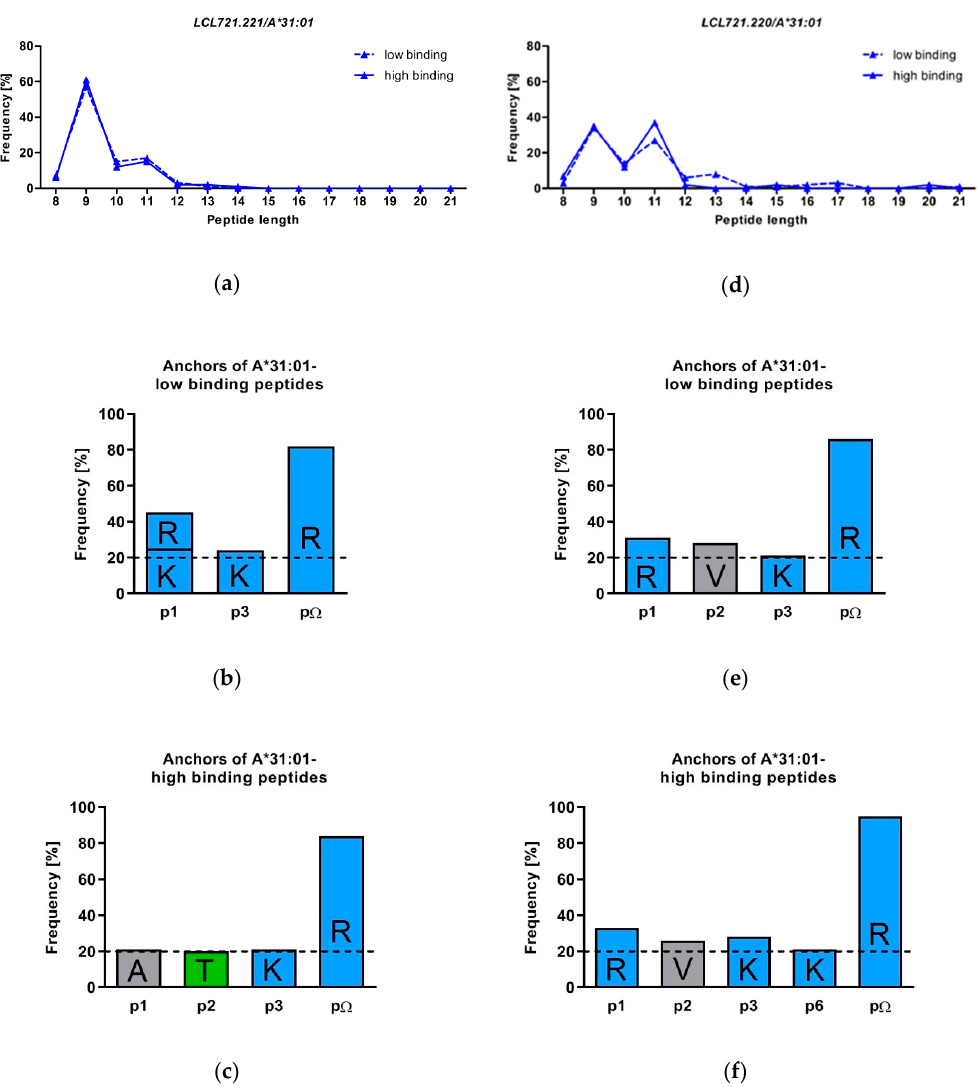
Figure 2. Analysis of the peptide repertoire of sA*31:01 ( a ) amino acids (AA) length of peptides presented by sA*31:01 in LCL721.221 cells; ( d ) AA length of peptides presented by sA*31:01 in TAP-deficient LCL721.220 cells. Peptides are distinguished into low binding and high binding peptides; ( b , c ) Peptide anchors of sA*31:01 low and high binding peptides produced in LCL721.221 cells; ( e , f ) Peptide anchors of sA*31:01 low and high binding peptides produced in LCL721.220 cells. The single letter code is used for AAs. Polar positive (blue), polar neutral (green), nonpolar aliphatic (gray) and nonpolar aromatic (purple) AAs with a frequency above 20% (dashed line) are colored in the same color.